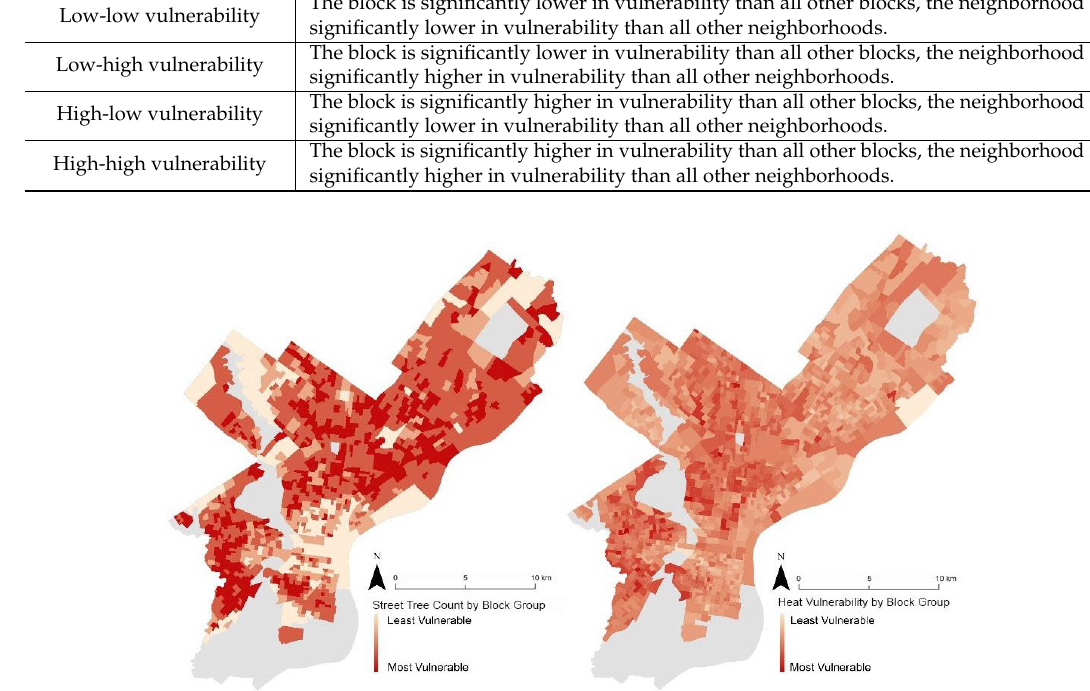
Table 1. Spatial Cluster and Outlier Analysis, or Anselin Moran’s I, outputs and descriptions.